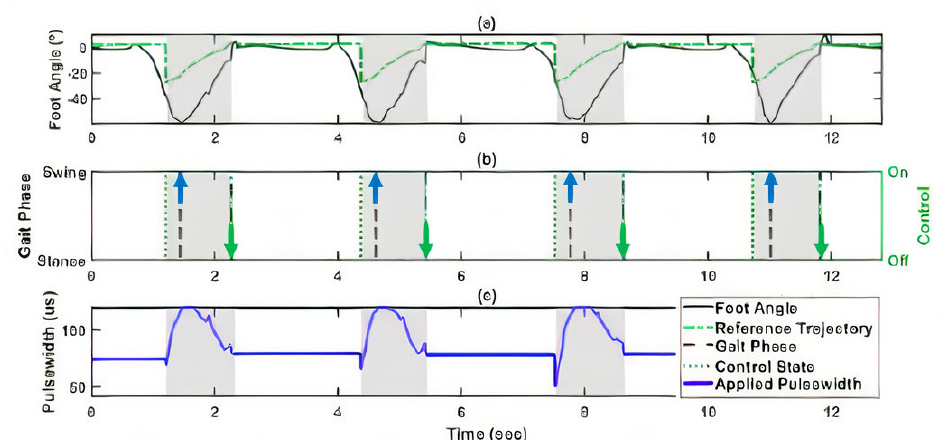
Figure 10. Real-time trajectory tracking control strategy validation at 1 km/h: ( a ) Measured foot angle (black solid line) and reference foot angle trajectory (dashed green line). ( b ) Control activation (Gait phase and Control State). The vertical dashed line with blue arrow represents stance-swing transition, while the green arrow indicates the swing-stance transition. ( c ) Applied pulse width.